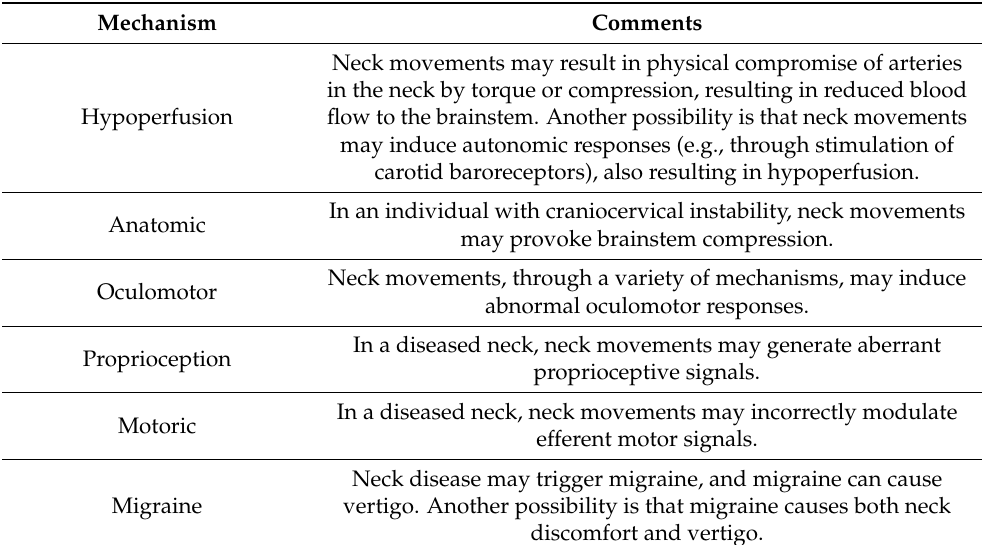
Table 1. A selection of pathophysiological mechanisms proposed for